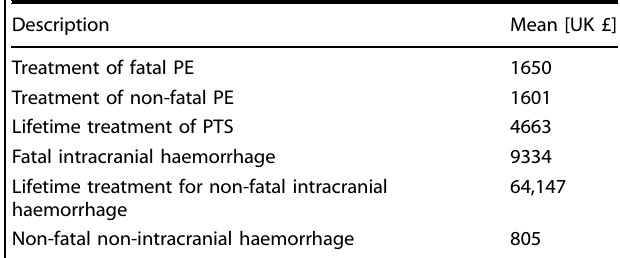
Table 15. Costs associated with outcomes of DVT and complications associated with the treatment of